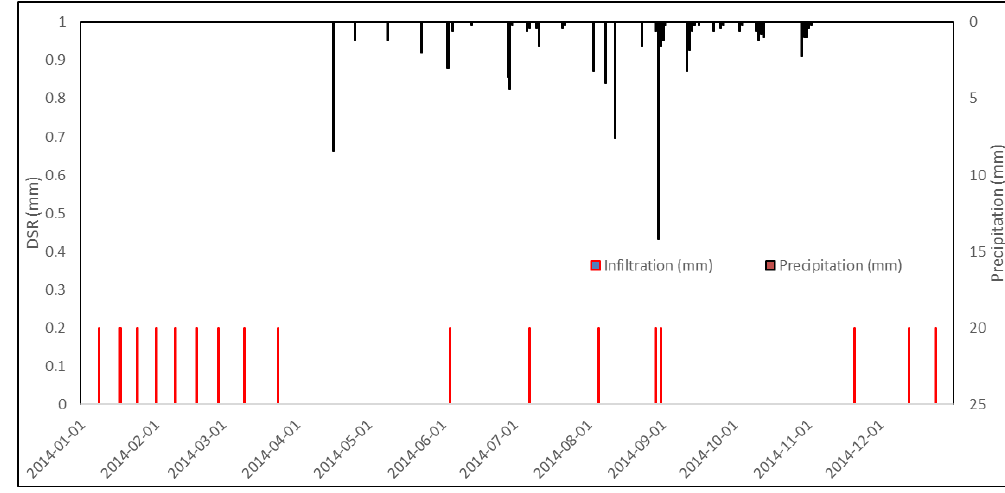
Figure 5. Relationship between precipitation and DSR in 2014.